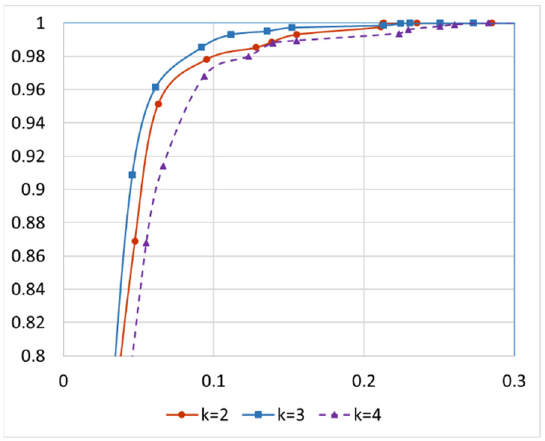
Figure 10. ROC curve of incorrect scene detection using different number of nearest neighbors k . Figure 11. Ablation study on incorrect scene detection.